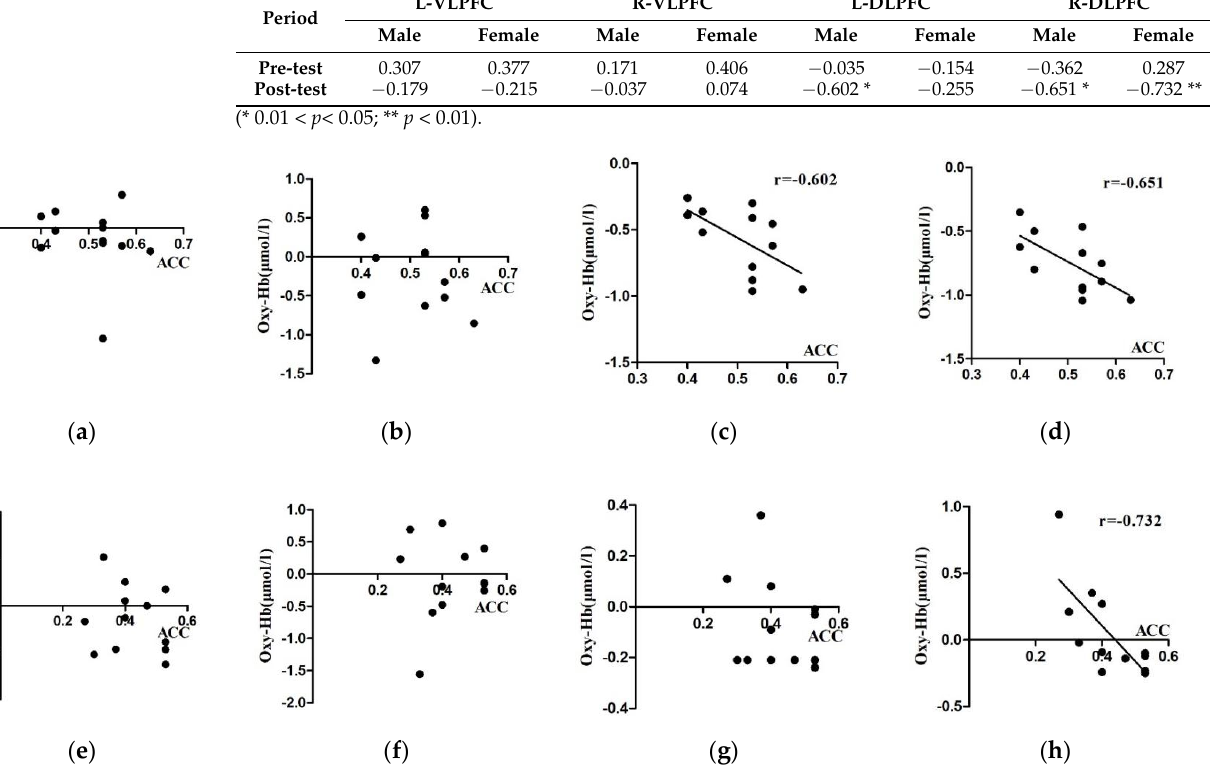
Table 6. Correlation results between fNIRS and behavioral (Pearson’s correlation coefficient r).